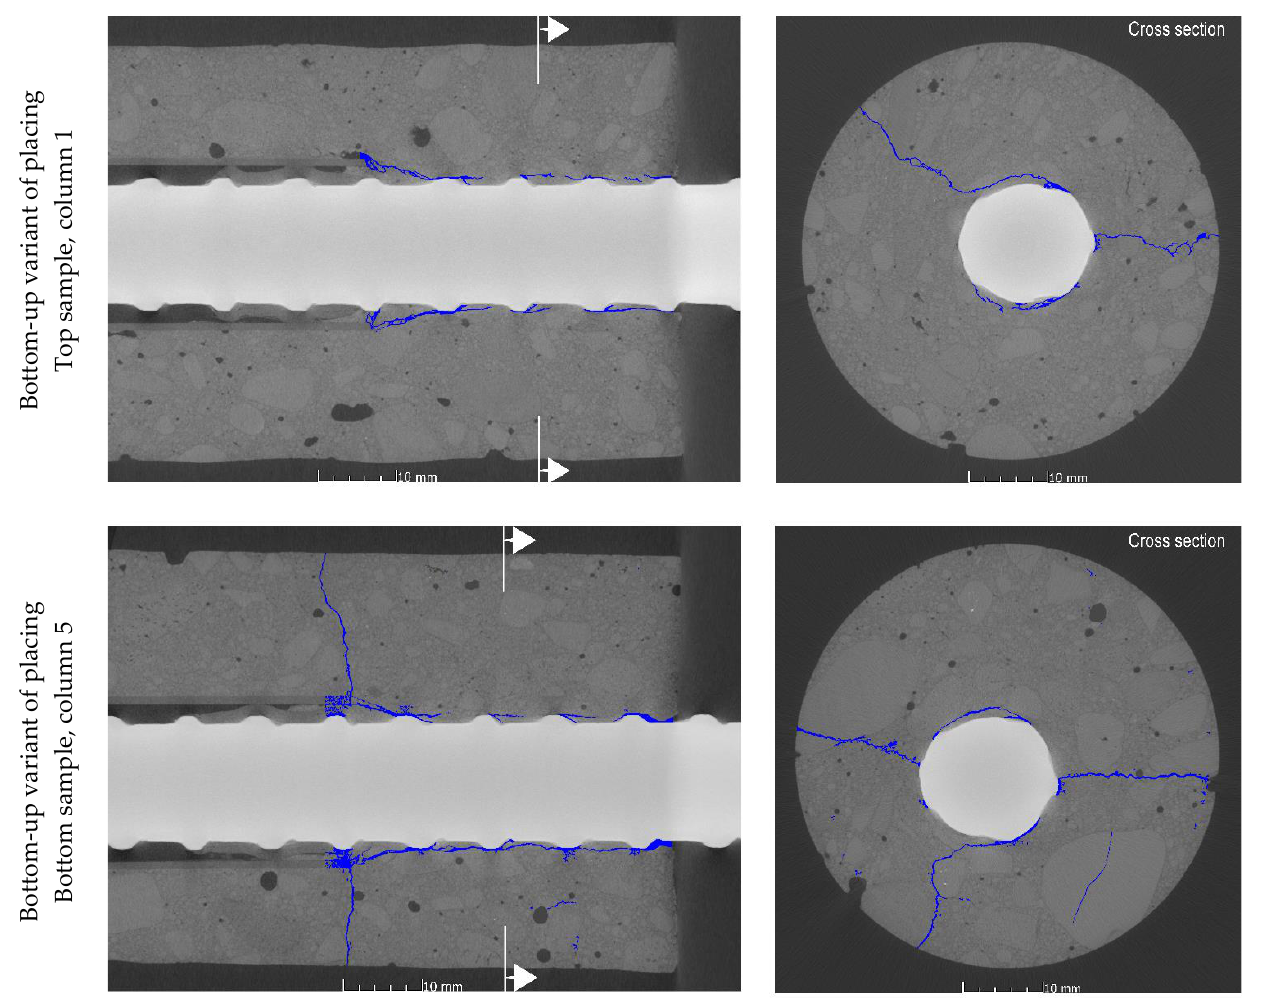
Figure 7. Examples of tomography sectioning of concrete cores extracted from the test panel.